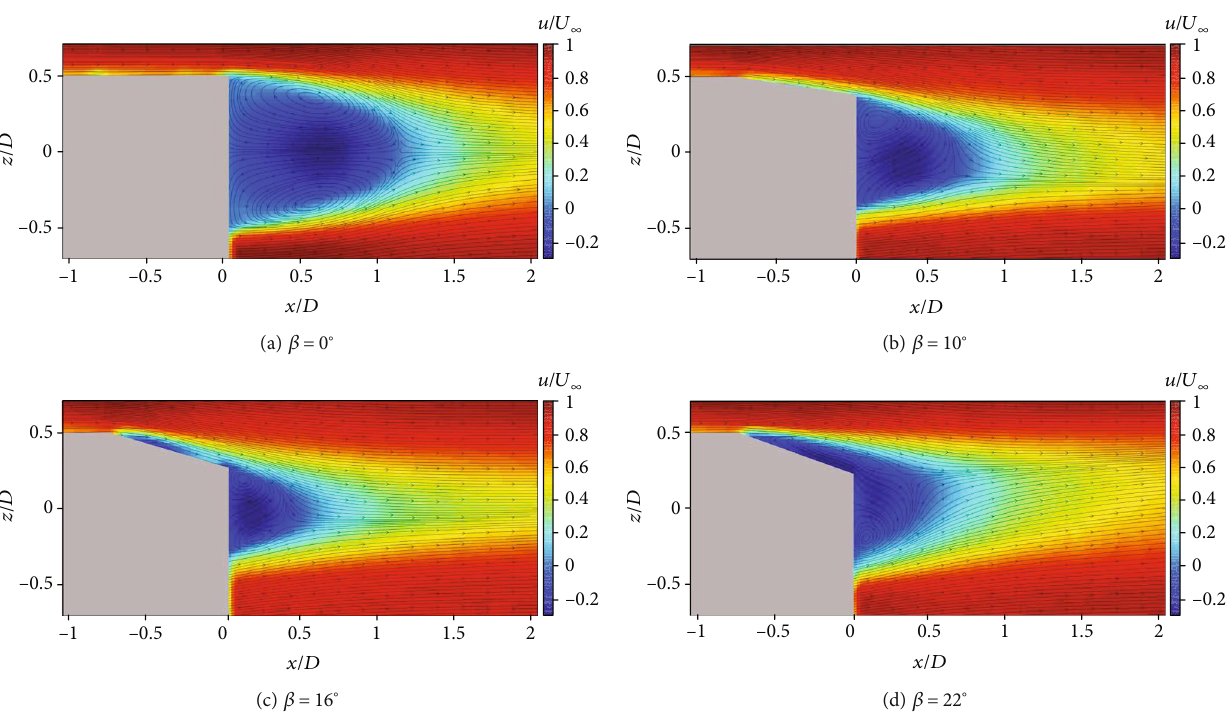
Figure 6: Time-averaged streamline velocity magnitude at di ff erent boattail angles (a) β = 0 ° , (b) β = 10 ° , (c) β = 16 ° , and (d) β = 22 ° .